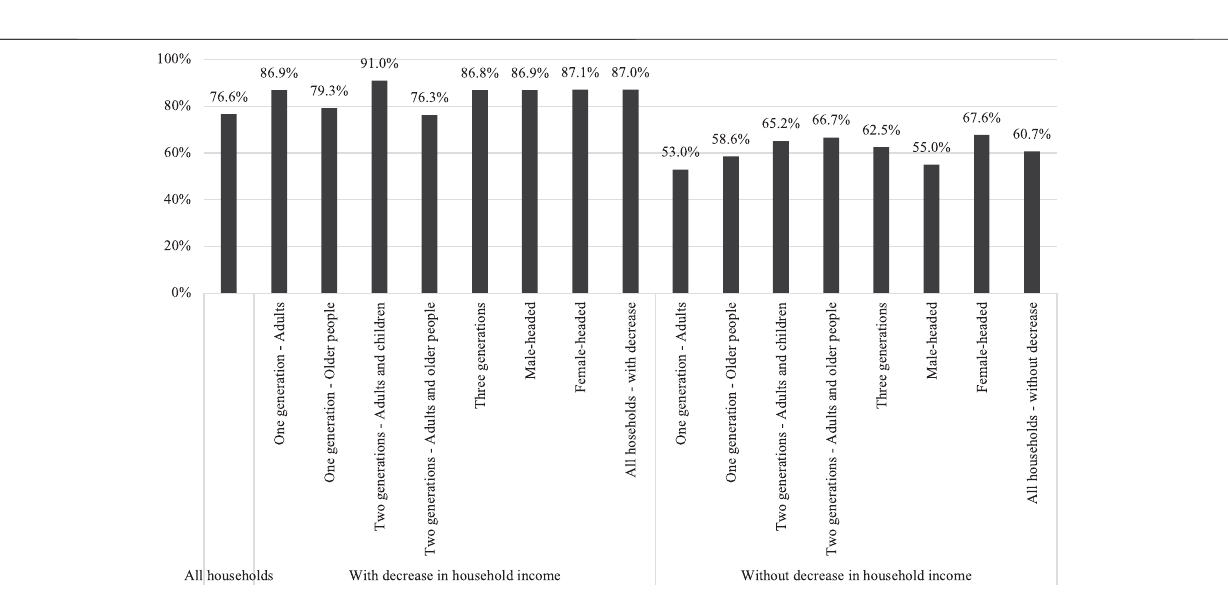
Frontiers in Sociology |